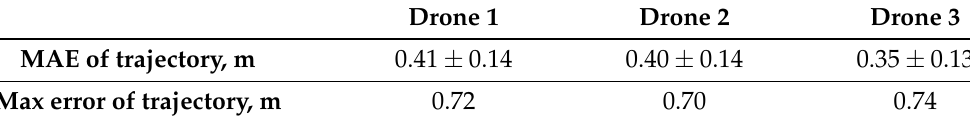
Table 1. Mean absolute error and maximum error of trajectory in comparison to ground